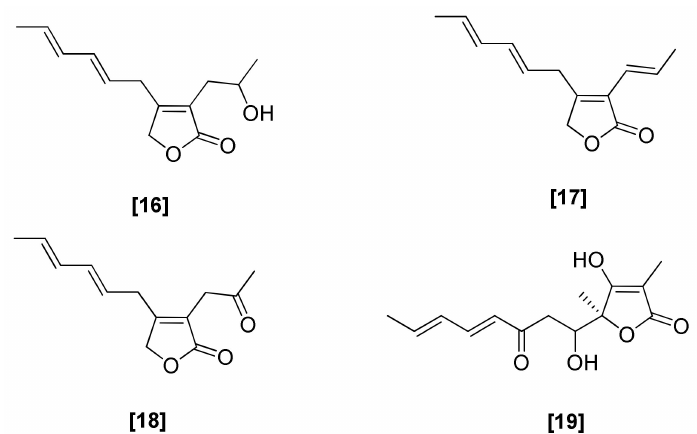
Figure 4. Structures of antifungal butenolides from Trichoderma spp. [16]: harzianolide, [17] dehydro-derivative of harzianolide, [18] T39butenolide, [19] 5-hydroxyvertinolide butenolides; [16], [17], and [18] were isolated from T. harzianum and [19] was isolated from T. longibrachiatum .